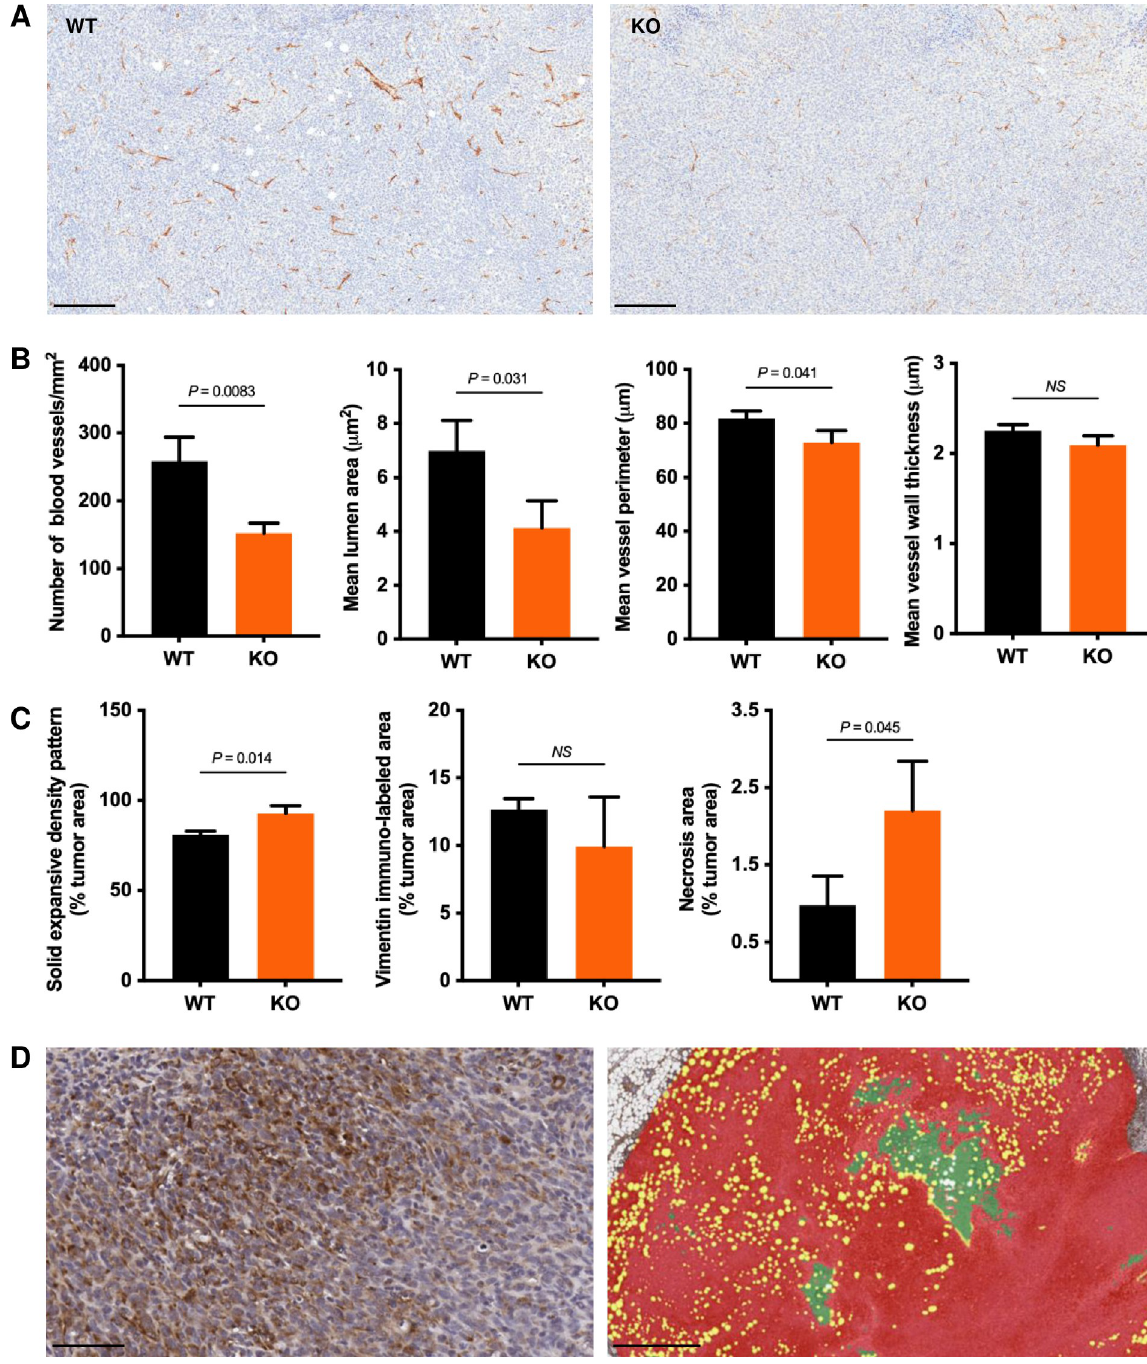
Fig 3. Clic4 host deficiency impairs neovascularization of the primary tumor. ( A ) Representative CD31 immunostaining in primary tumors from Clic4 wildtype (WT) and knockout (KO) tumor-bearing mice at 28 days post-implantation. Scale bar, 200 μ m. ( B ) Quantification of tumor vascularization in primary tumors from Clic4 wildtype (WT) and knockout (KO) tumor-bearing mice at 28 days post-implantation (n = 3 per group). Values represent the mean ± s.d. from whole tissue sections analyzed by Image Scope. P values were obtained after unpaired t test. ( C ) Quantification of solid tumor expansive density area, vimentin immuno-labeled area, and necrosis area in primary tumors from Clic4 wildtype (WT) and knockout (KO) tumor-bearing mice at 28 days post-implantation (n = 3 per group). Values represent the mean ± s.d. from whole tissue sections analyzed by HALO imaging software. P values were obtained after unpaired t test. ( D ) Representative vimentin immunostaining (left) and pseudo-colored analysis mask (right) showing the segmentation of tumor (red), necrosis (green), and intervening loose areolar and adipose connective tissue areas (yellow) in primary tumors that were used for the quantification shown in ( C ). Scale bars, 50 μ m (left) and 500 μ m (right). https://doi.org/10.1371/journal.pgen.1010271.g003 PLOS Genetics | https://doi.org/10.1371/journal.pgen.1010271 June 21,